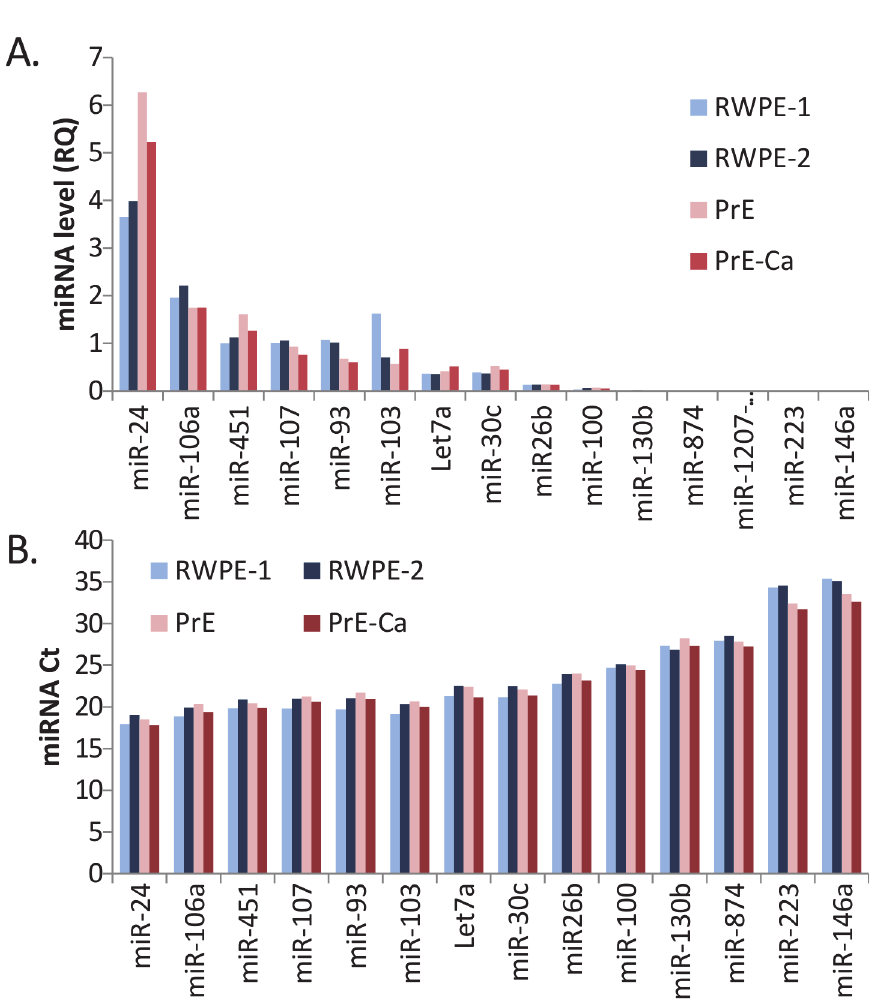
Fig 4. Most of the 14 miRNAs were abundant in cultured epithelial cells from both benign and malignant prostate and the expression did not vary be disease. A, relative quantification (RQ) of the miRNA expression in two isogenic benign/PCa pairs; RWPE-1 (benign), RWPE-2 (PCa), PrE (benign) and PrE-Ca (PCa). B , raw Ct values for the miRNAs in the same